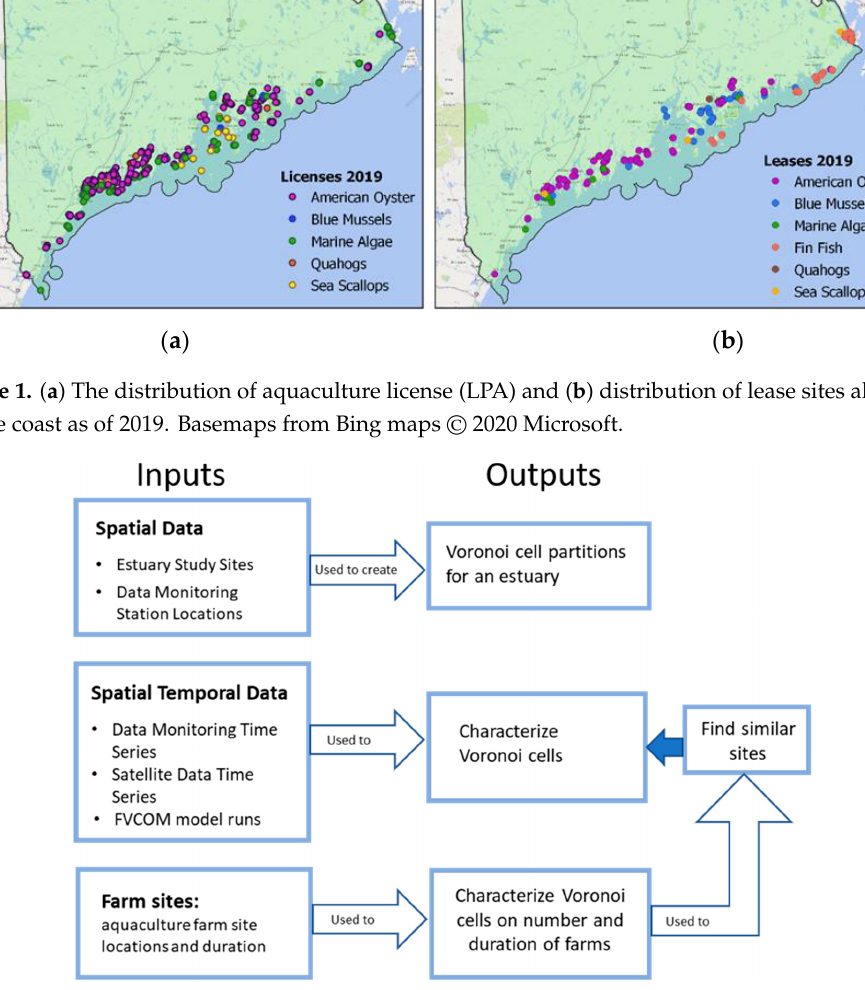
Figure 2. Overview of integration framework. We partition coastal estuaries into Voronoi cells and summarize spatial and temporal data sets for the Voronoi cells. Existing aquaculture site information is also summarized for each Voronoi cell. Cells with aquaculture sites serve as targets for finding cells sharing similar physical